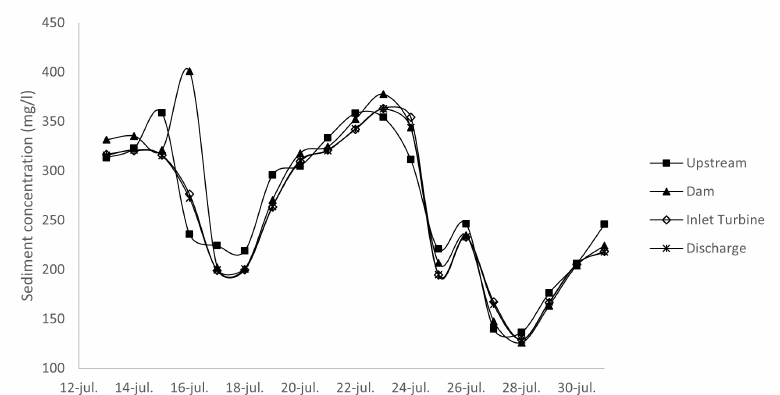
Figure 2. Sediment concentration in July